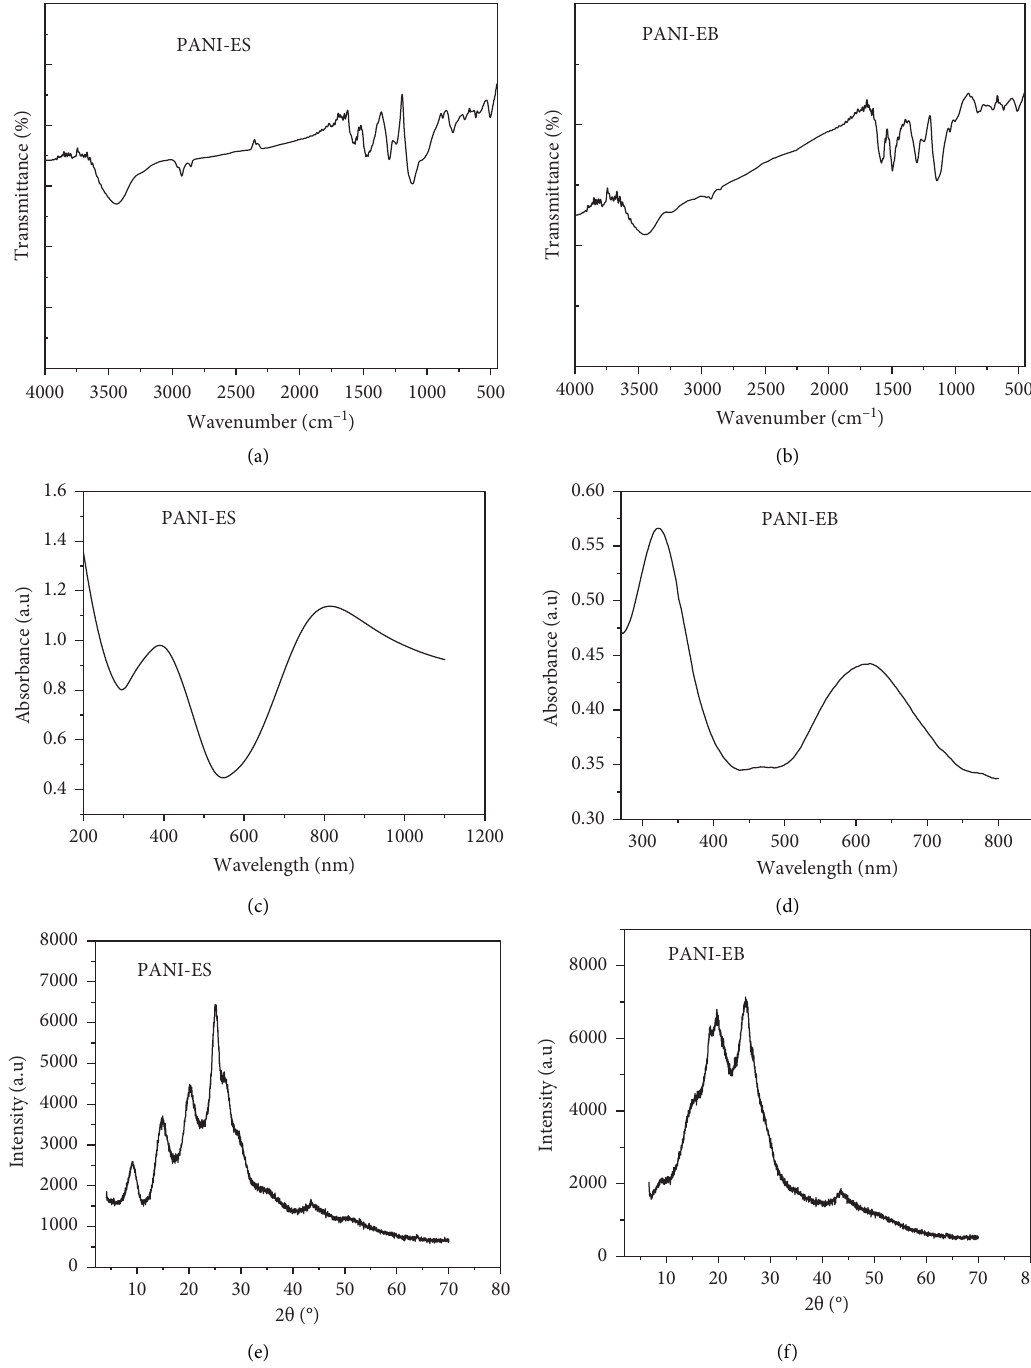
Figure 3: (a), (b) FTIR spectra, (c), (d) UV-VIS spectra, and (e), (f) XRD diffractograms of PANI-ES and